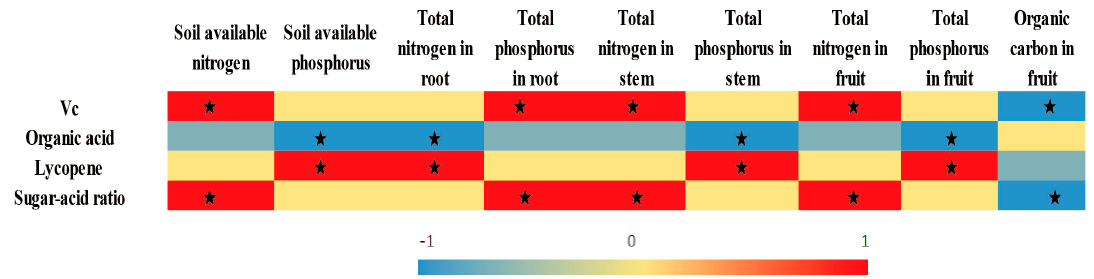
Figure 6. Correlation analysis between tomato fruit quality and soil and plant nutrient content. Note: Different color depth mean correlation difference, correlation value is showed by the value of number from − 1 to 1, ★ means significance correlation ( p < 0.05) correlation.